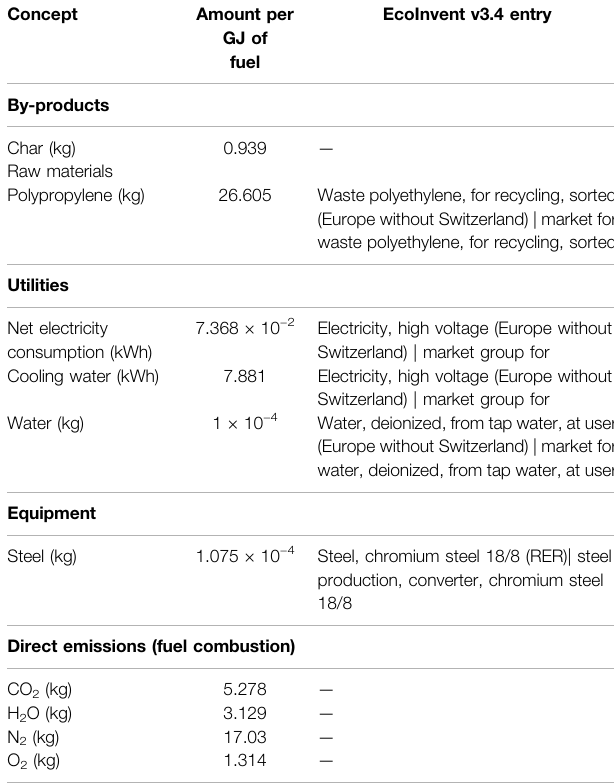
TABLE 5 | Net fl ows of the PP pyrolysis process and EcoInvent entries used for modeling and LCA. Concept Amount per GJ